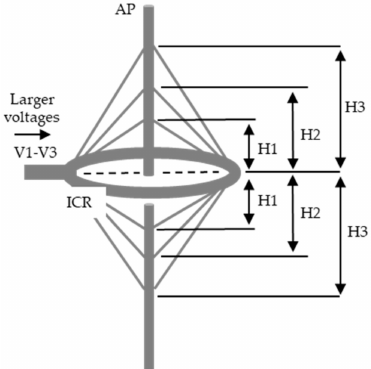
Figure 6. Conceptual representation of conical electric fields symmetrically formed above and below to form conic electric fields of di ff erent heights (H1–H3, corresponding to V1–V3, respectively). The height of the field was determined by the pole-ascending–descending (or pole-descending / ascending) action of the test